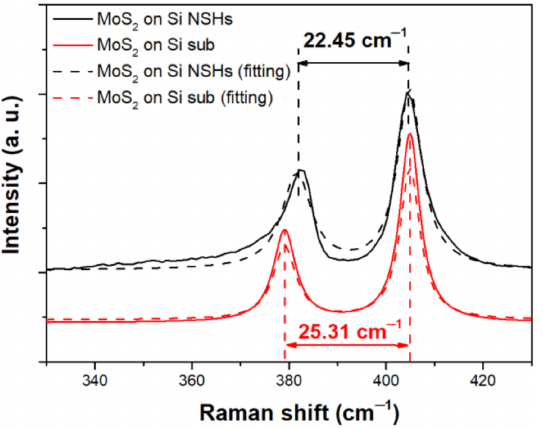
Figure 2. Raman spectra and corresponding Gaussian fitting results of few-layer MoS 2 decorated with Au NPs/Si NSHs.